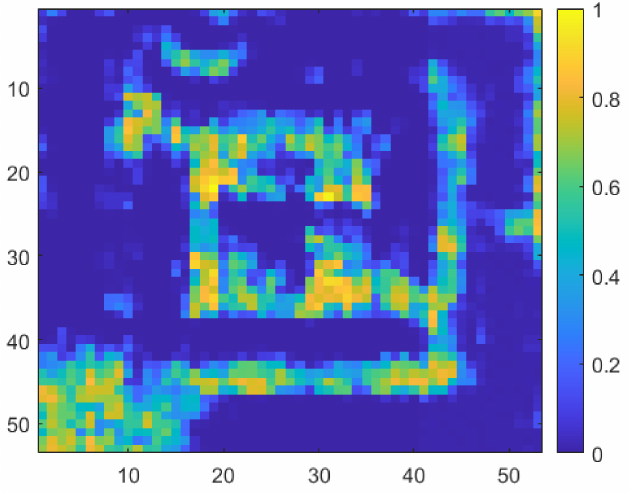
Figure 14. Imaging measurement using the proposed concurrent-mode detector at 200 GHz.